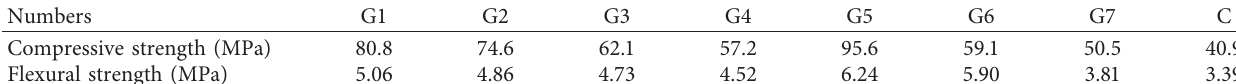
Table 9: Compressive strength and flexural strength of each specimen cured at 60 ° C for 28